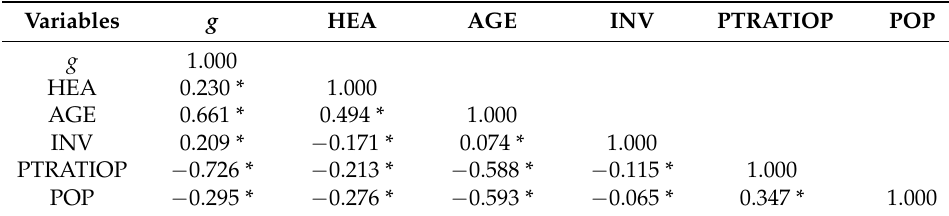
Table 2. Pairwise correlation.